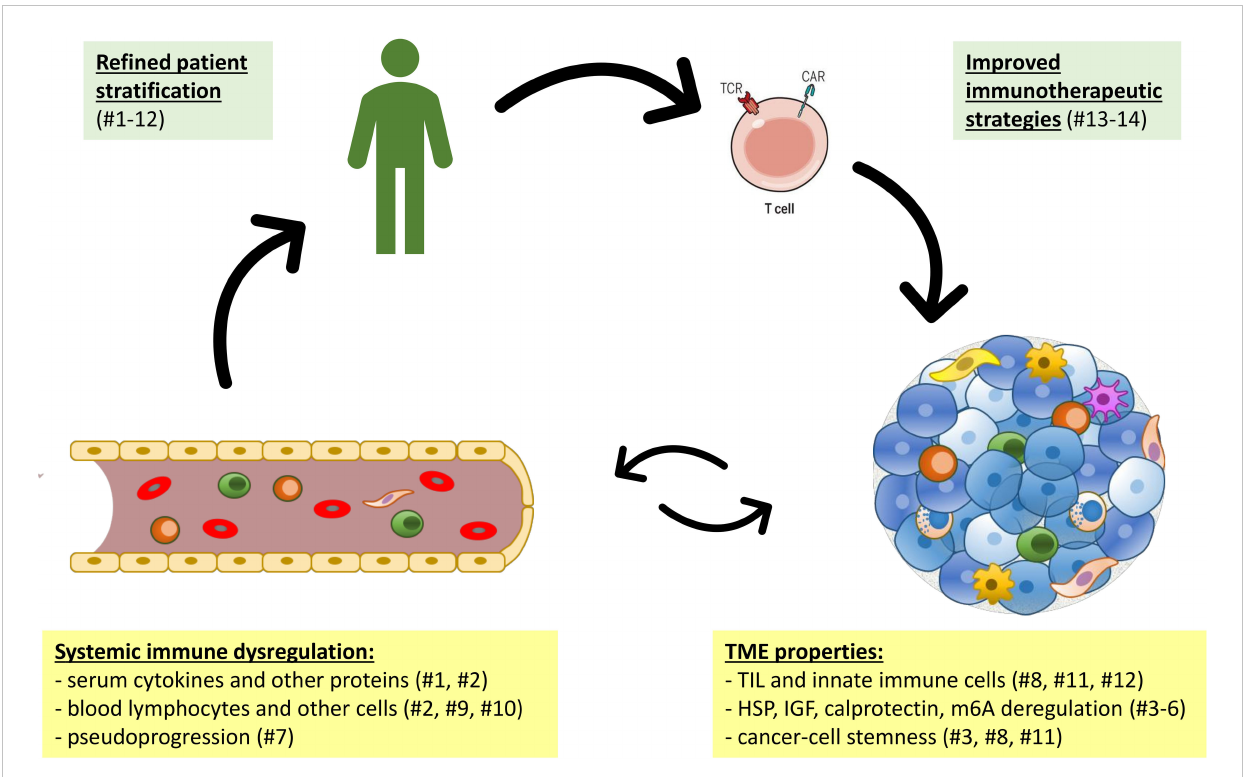
FIGURE 1 The interplay of systemic immune dysregulation and the tumor microenvironment (TME) of cancer as basis for clinical exploitation. Articles of the current research topic are shown in parentheses numbered according to Table